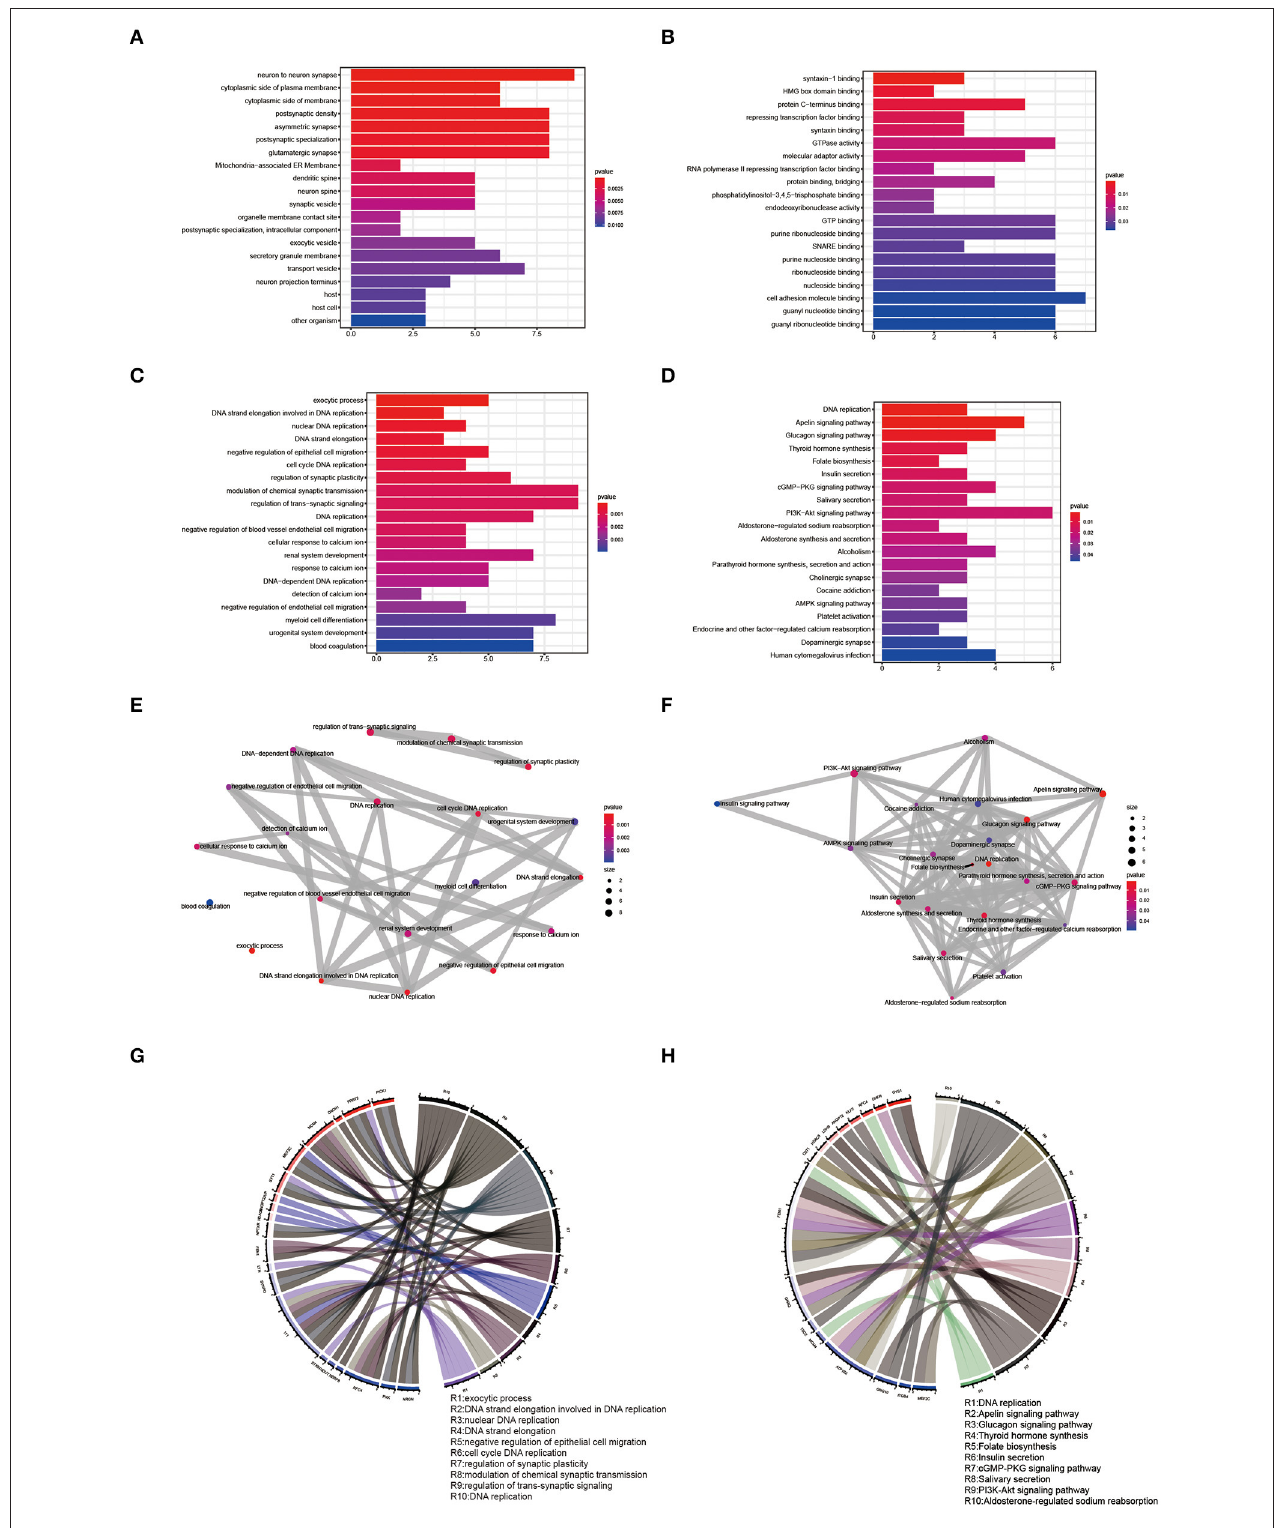
FIGURE 5 | GO term and KEGG pathway enrichment analysis of shared genes. (A–C) Results of CC, MF, and BP of the GO term enrichment analysis of shared genes, respectively. (D) Results of KEGG pathway enrichment analysis of shared genes. (E,F) Correlation analysis of the GO BP term and KEGG pathway enrichment analysis results of shared genes. (G,H) Top ten GO BP term enrichment analysis results and the top ten KEGG pathway enrichment analysis results and their corresponding shared genes.